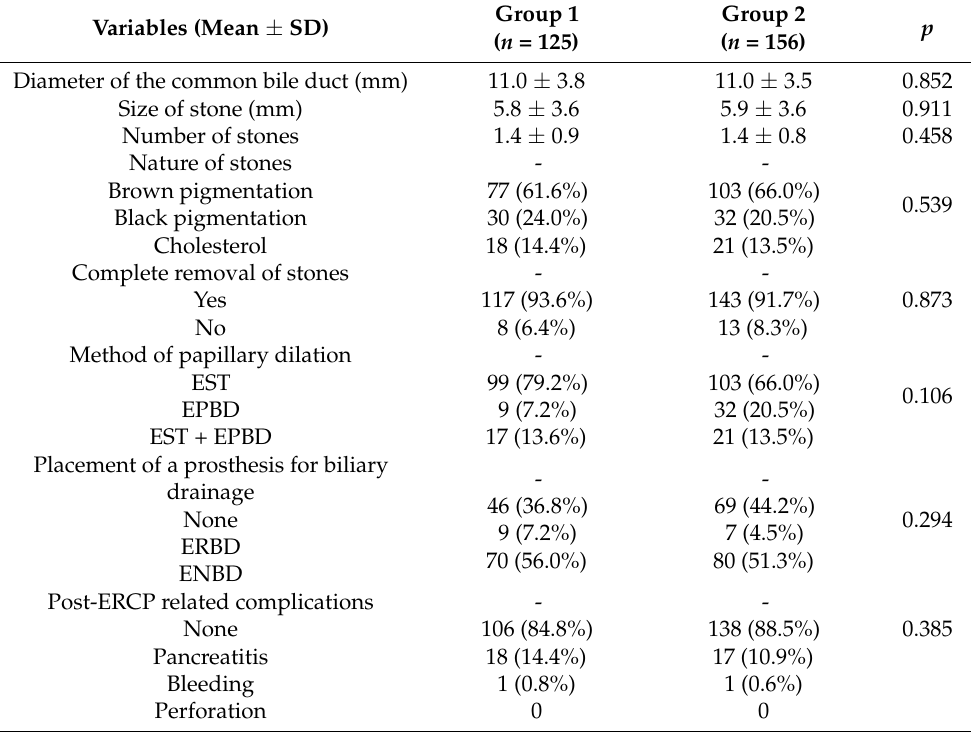
Table 4. Comparison of the procedure-related factors between the two